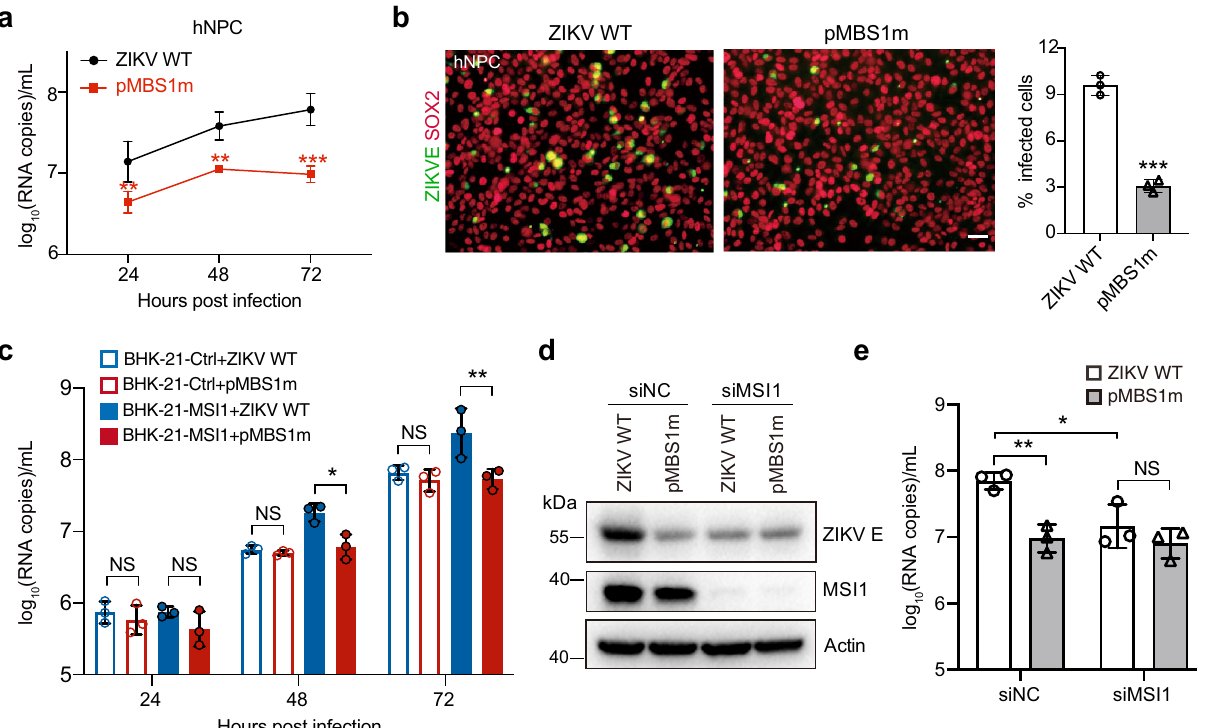
Fig. 2 | The pMBS1m mutation attenuates ZIKV replication in cells with MSI1 expression.a hNPCswereinfectedwiththeZIKVWTorpMBS1mviruses(MOI=1), and the culture supernatants were harvested at the indicated time points for detection of viral RNA copies by qRT-PCR. Data are mean±SD. n =3 independent experiments. Two-way ANOVA, ** P <0.01, *** P <0.001. (24h P =0.0083; 48h P = 0.0054; 72h P =0.0002). b The expression of viral envelope protein at 48h after infection from (a) was detected by immunostaining. Scale bar, 50 um. Data are mean±SD. Two-sided Student ’ s t test, *** P <0.001. ( P =0.0001). c BHK-21-Ctrl and BHK-21-MSI1cellswereinfectedwiththeZIKVWTorpMBS1mviruses(MOI=0.01), andculturesupernatantwasharvestedattheindicatedtimepointsfordetectionof viral RNA copies by qRT-PCR. Data are mean±SD. n =3 independent experiments.